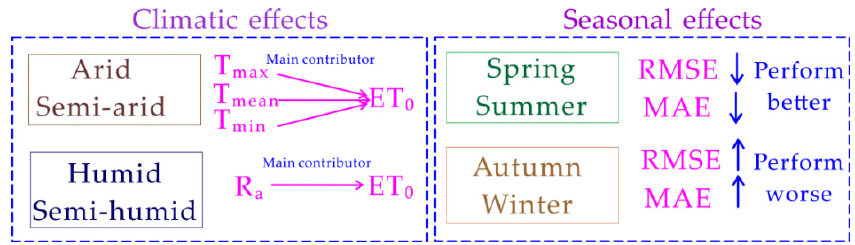
Figure 7. Graphic showing climatic and seasonal effects on ET 0 estimation of models.